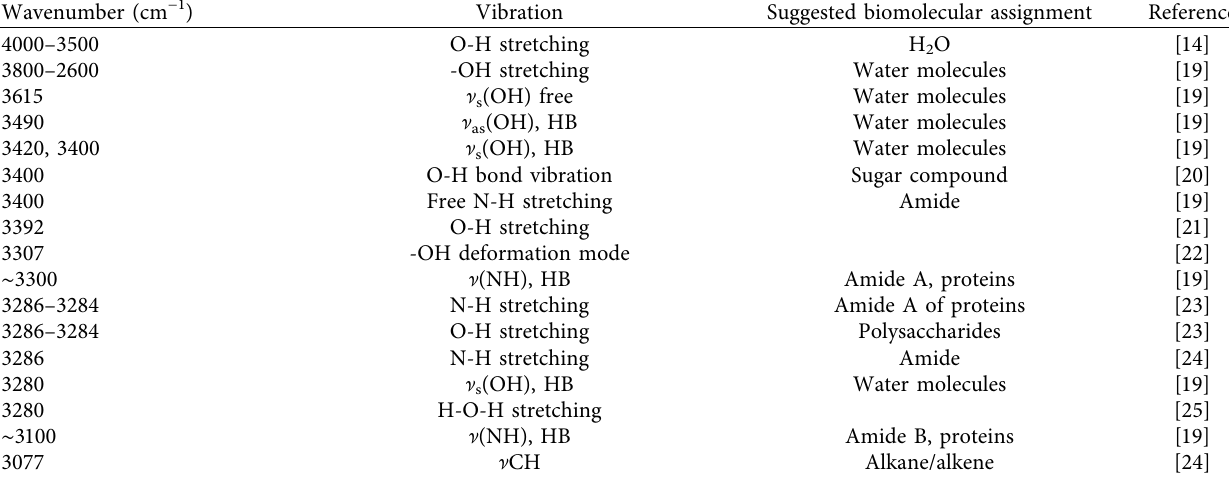
Table 2: Infrared spectrum band